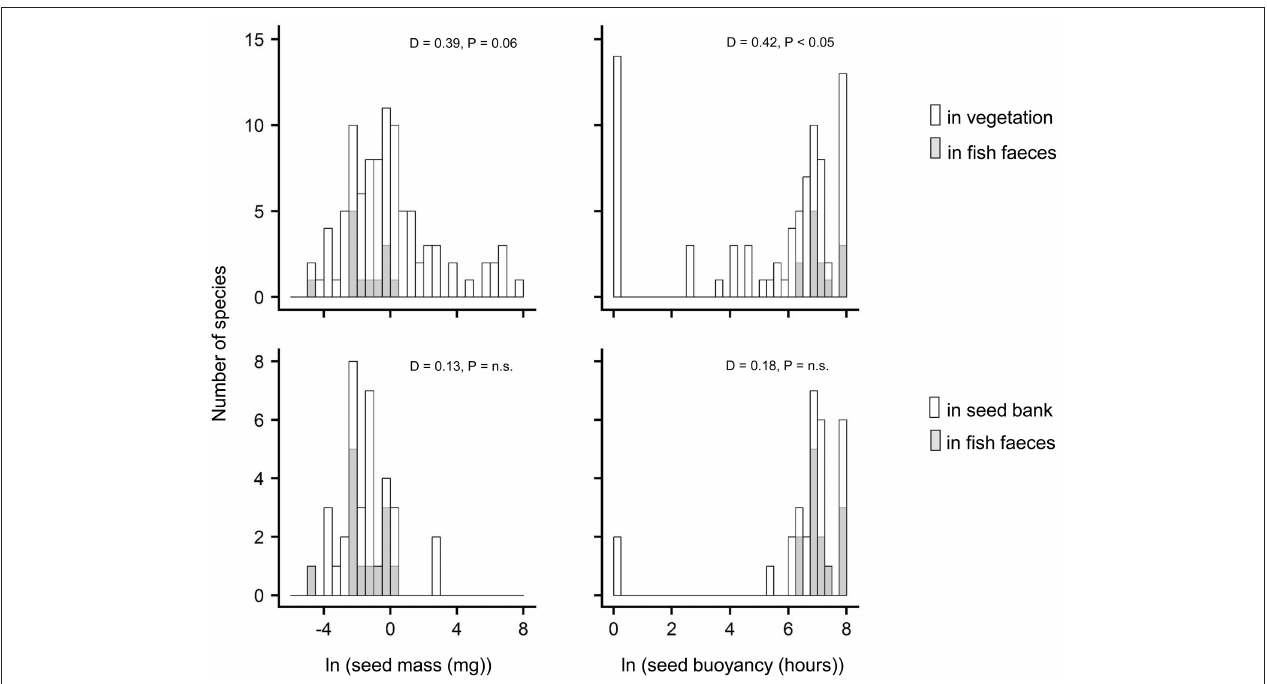
FIGURE 5 | Frequency distribution of seed mass and seed buoyancy for number of vascular plant species in fish feces, vegetation, and the seed bank. Distributions were compared with Kolmogorov’s two sample test; outcomes are indicated by the D -values and their significance in each panel. n.s. = not significant.